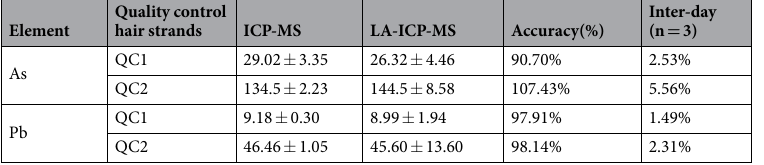
Table 2. Comparison of analyte concentration in quality control hair strands measured by LA-ICP-MS (via the calibration curve obtained from matrix matched hair standards) with the values measured by ICP-MS. Values in μ g/g.